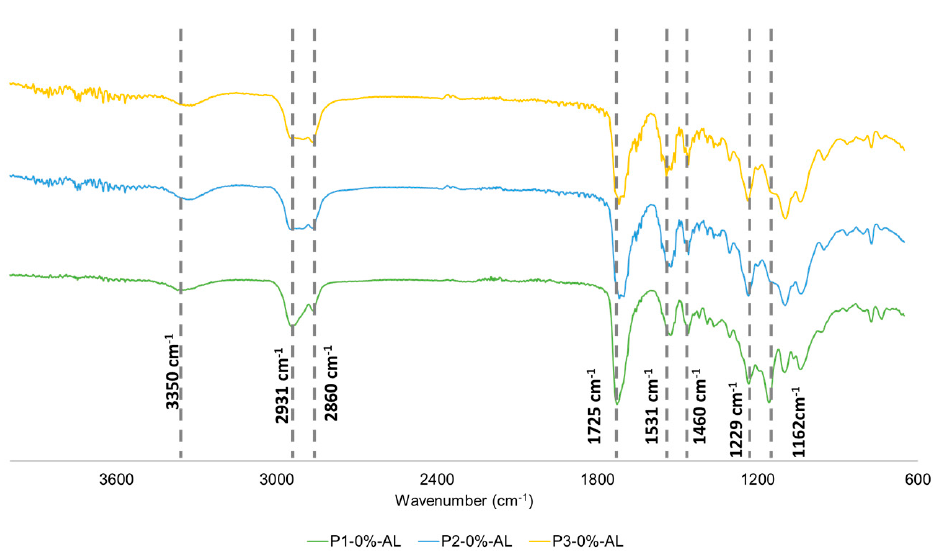
thermograms of potato starch, which presented a peak between 80 ◦ C–110 ◦ C related to gelatinization, a phenomenon that refers to a loss of structural order in amylopectin and amylose chains, depending on the content of moisture. Therefore, the peak absence in AL-Z and AL-N in Figure 1D after 80 ◦ C indicated that samples do not present moisture and are thermally stable. Images obtained by SEM showed that potato starch (Figure 1E) has a spherical shape and smooth surface with a particle size of 24.4 ± 7.5 µ m ( n = 10). In contrast, AL-Z (Figure 1F) exhibited a porous surface and a non-uniform shape with a particle size of 88.5 ± 14.3 µ m ( n = 10), which is greater than AL-N. After the obtention of AL-Z, polyurethane composites were synthesized and evaluated by ATR-FTIR. Figure 2 shows FTIR spectra of polyurethanes P1, P2, and P3 without fillers, where FTIR bands in 3350 cm − 1 (N-H stretching), 1725 cm − 1 (C=O stretching), and 1531 cm − 1 (N-H flexion) confirmed the obtention of polyurethanes. The presence of PCL and PEG segments in polyurethanes was observed in FTIR spectrums, in which the ester group of PCL is related to peaks at 1229 cm − 1 (C-C(O)-O asymmetric stretching), and the increase in the intensity of the band at 1725 cm − 1 (only in P1); moreover, the ether group is assigned to the band at 1162 cm − 1 (C-C-O asymmetric stretching) [19,30]. The absence of the 2225 cm − 1 peak assigned to the isocyanate group suggests that the IPDI completely reacted; that must be ensured due to the cytotoxic effect of that compound [31]. Finally, S. Arevalo-Alquichire et al. [12] acquired similar results for polyol compositions similar to the ones used in this study.